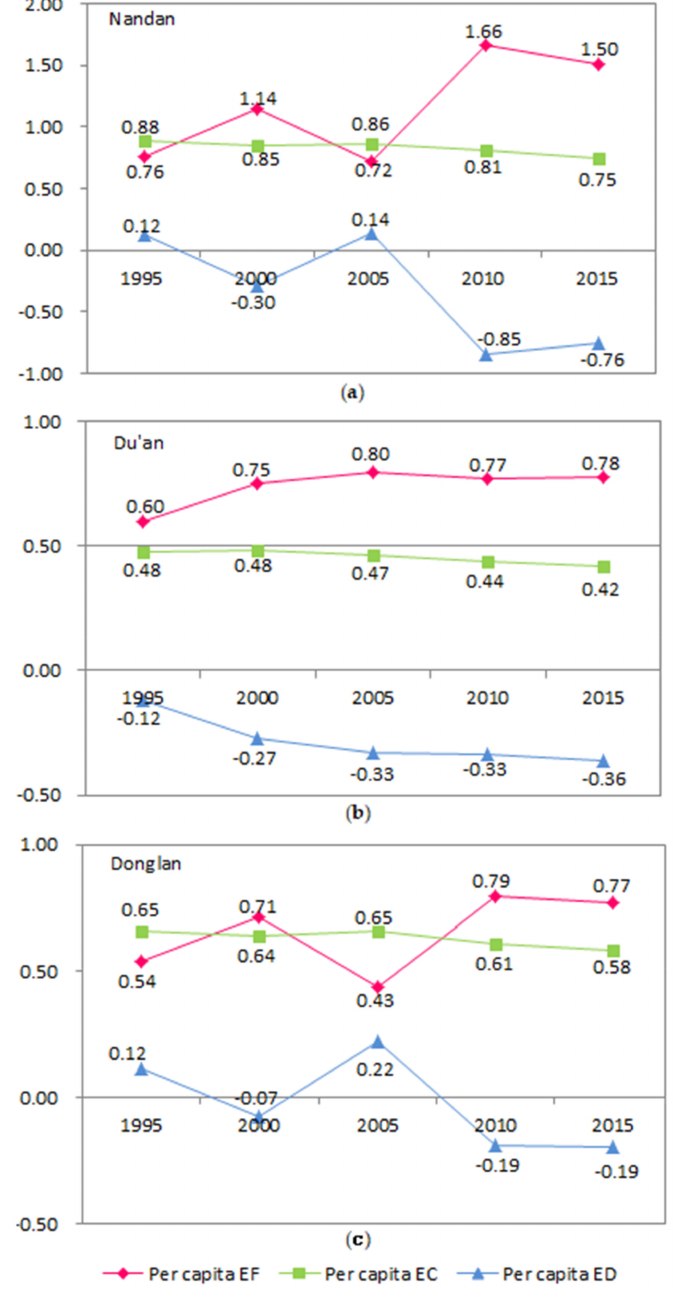
Figure 8. ( a ) Trends of the per capita, EF, EC, and ED of Nandan County; ( b ) trends of the per capita, EF, EC, and ED of Du’an County; ( c ) trends of the per capita, EF, EC, and ED of Donglan